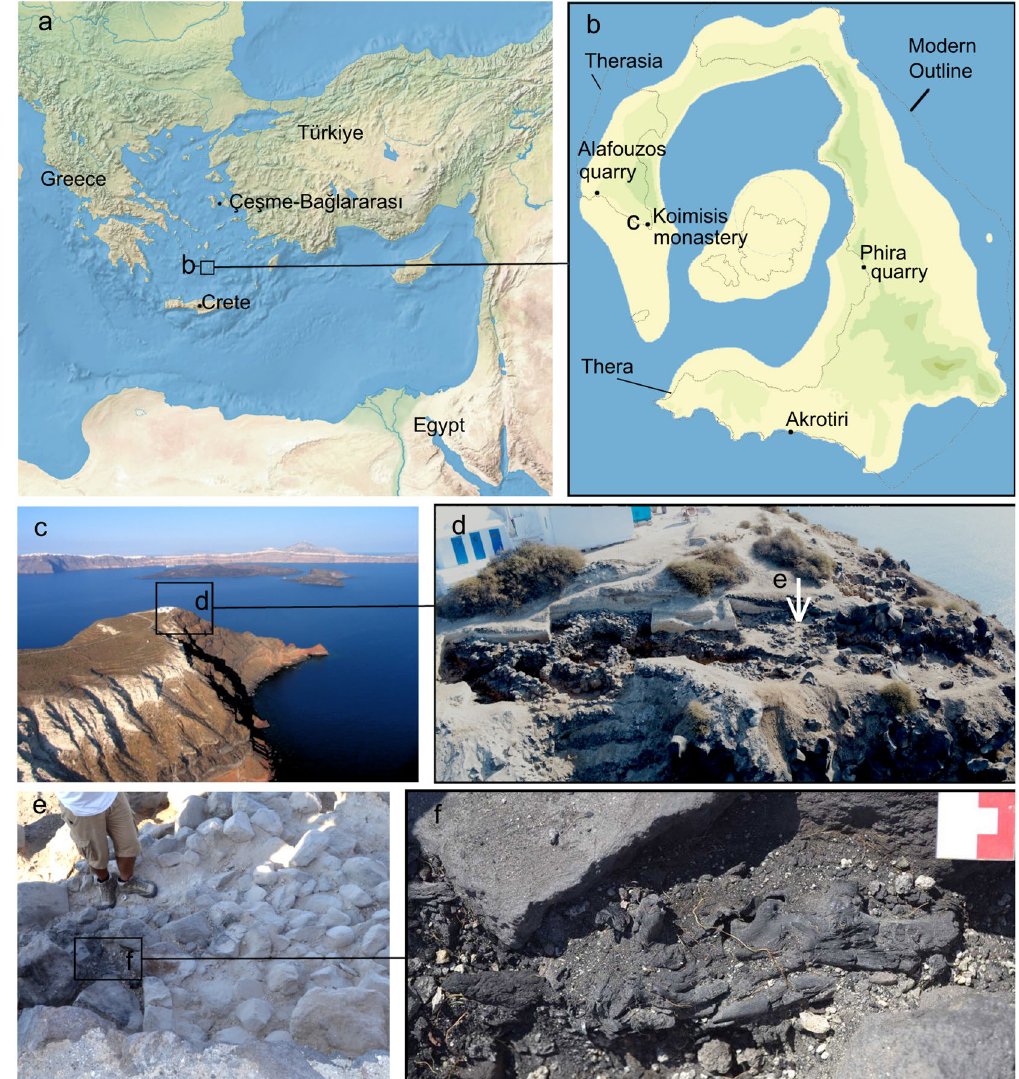
Figure 1. The location of Thera ( a , b ), Koimisis ( c ) and the olive shrub ( d , e ). Localized burning associated with the olive remains ( e ) and the olive shrub remains in situ ( f ). Image credit: